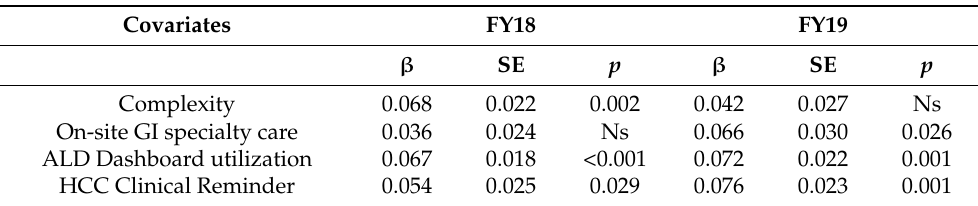
Table 3. Multivariable linear regression models of HCC surveillance rates in fiscal years 2018 and 2019